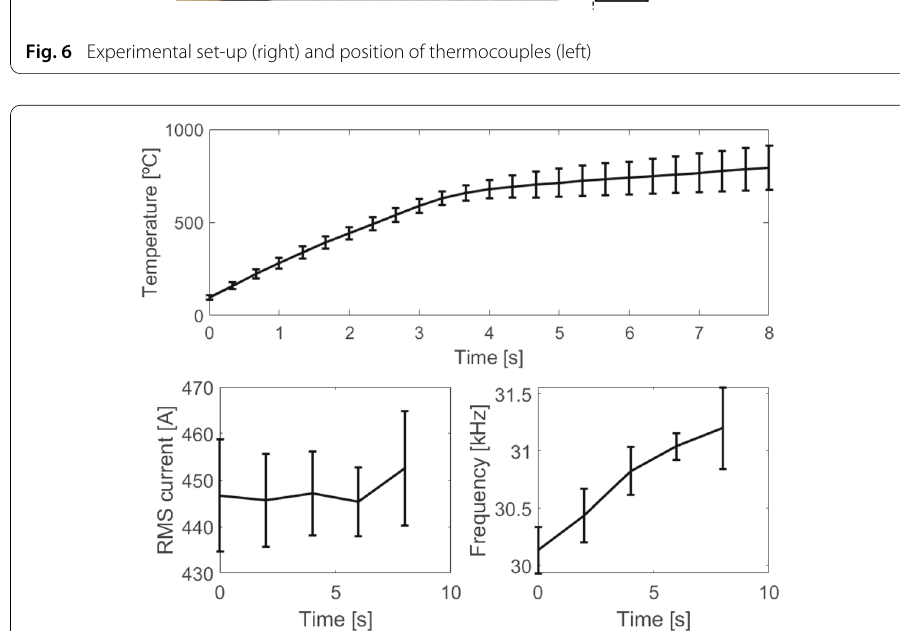
Fig. 7 Temperature (above), current (lower left) and frequency (lower right) evolution during the induction heating experiments represented as mean value and standard